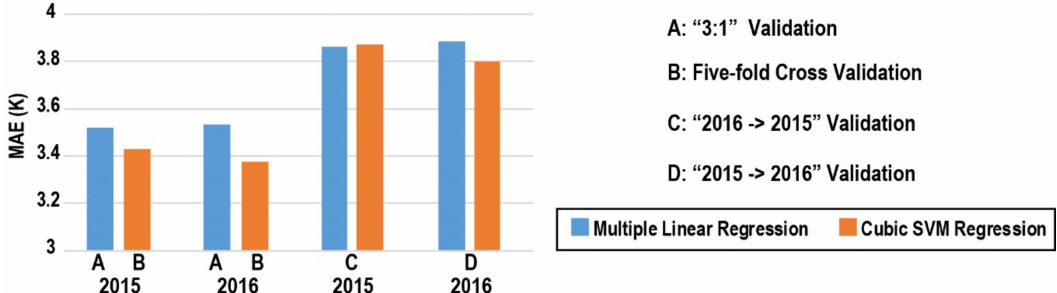
Figure 8. Comparison of the accuracy of two di ff erent regression tools (multiple linear regression and cubic support vector machines (SVM)